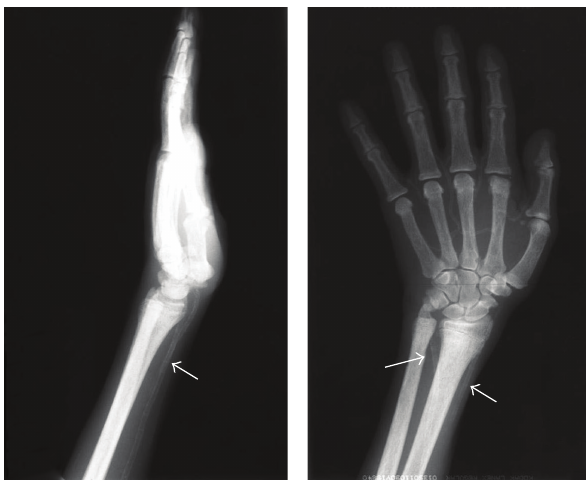
Figure 1: Radiographies of right hand reveal calcification of radial and ulnar (arrows) arteries and their distal branches.